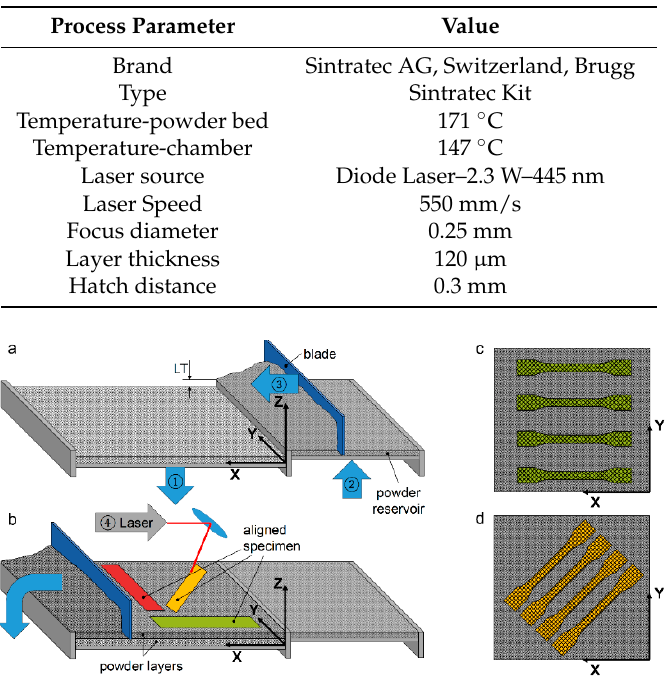
Figure 6. ( a ) Adjusting layer thickness LT and powder deposition; ( b ) removal of excessive material and sintering of specimens; ( c ) and ( d ) schematic arrangement of x- and x-y-specimens and scan